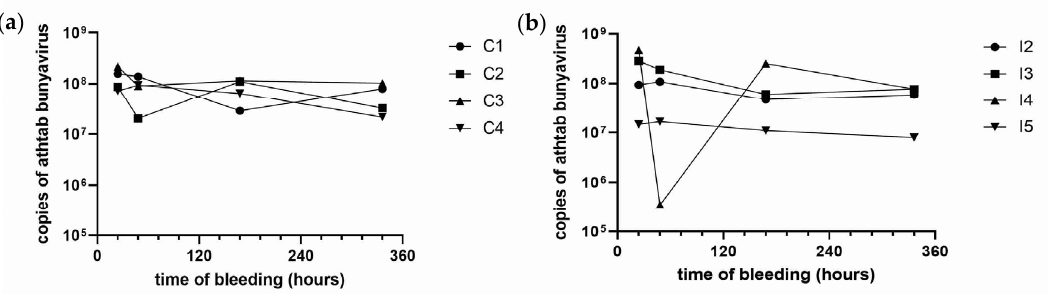
Figure 4. ( a ): Difference in copy number of Athtab bunyavirus from 4 bleedings in the control group: